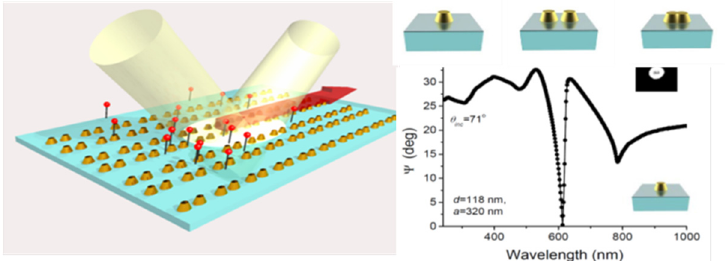
Figure 13. Schematic of the imagined experimental procedure of surface structuring: colloidal lithography ( a ), by using the Langmuir Blodgett technique ( b ), coupled to a controlled laser-assisted or thermal annealing de-wetting step ( c ), for various plasmonic and/or surface-enhanced Raman scattering resonators ( d ). Image partly adapted from Reference [125].